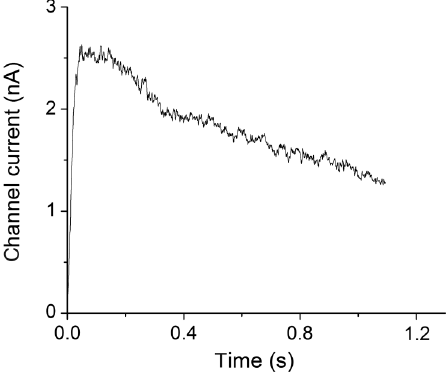
FIG. 3. A typical multichannel current trace. The depolarizing step potential was 60 mV; i.e., starting from a holding potential of (cid:2) 120 mV where channels are closed, the membrane potential is brought to þ 60 mV in one step at t ¼ 0 . The current shows a ‘‘fast’’ rise (an approximately 50 - ms time scale) corresponding to the stochastic opening of the channels, a plateau, and a ‘‘slow’’ exponential decay caused by the ‘‘inactivation’’ process. There are roughly 250 active channels in this